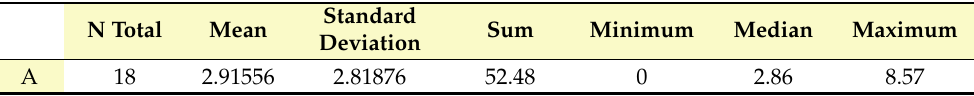
Table 4. Statistical analysis of mass loss